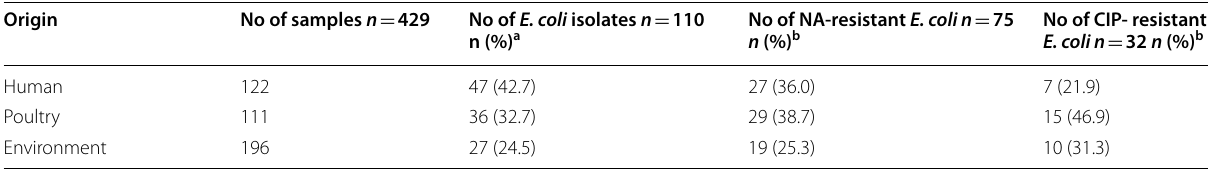
Table 1 Prevalence of nalidixic acid or ciprofloxacin-resistant Escherichia coli isolates from different sources characterized by disk diffusion and broth microdilution methods